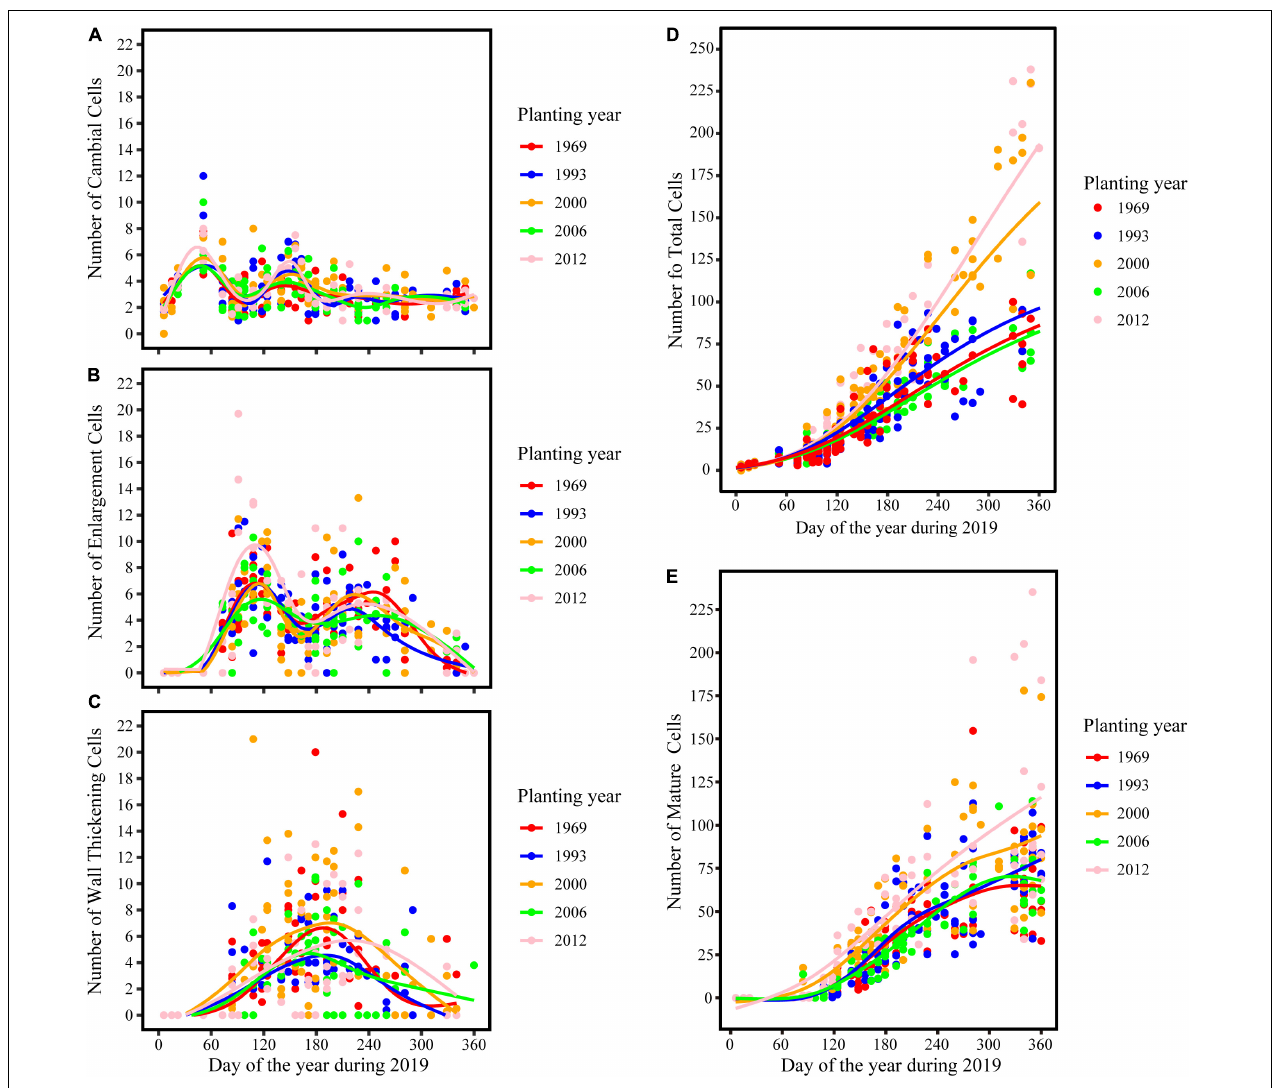
FIGURE 1 | Dynamics of different years of plantation establishment and aspects of wood cell development. (A) Cambial cells; (B) enlarging cells; (C) wall thickening cells; (D) total number of cells; (E) mature